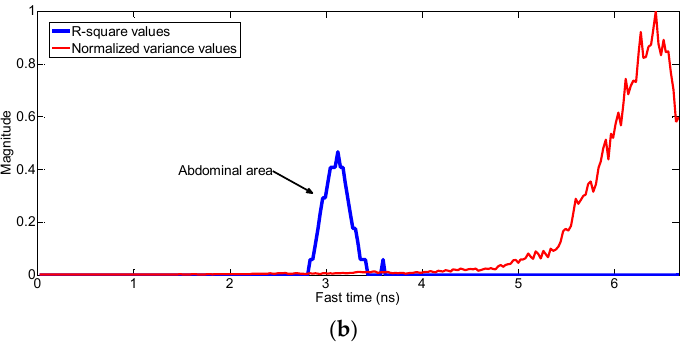
Figure 16. ( a ) Comparison of the vital signal obtained from the conventional vs proposed algorithm while the human is slightly moving ( b ) R-square and normalized variance values at each fast-time index during motion state.